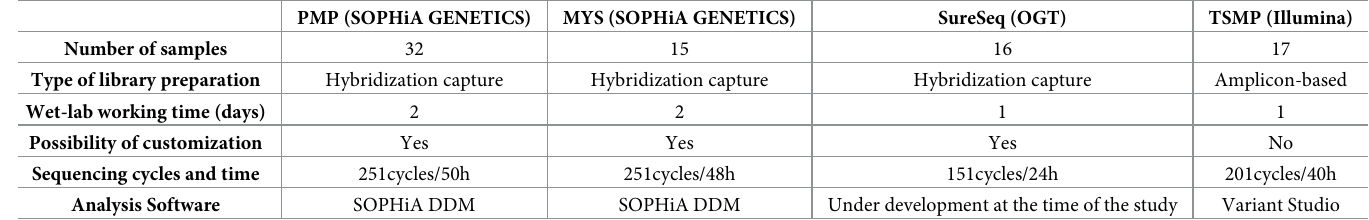
Table 2. Characteristics of panel performance.